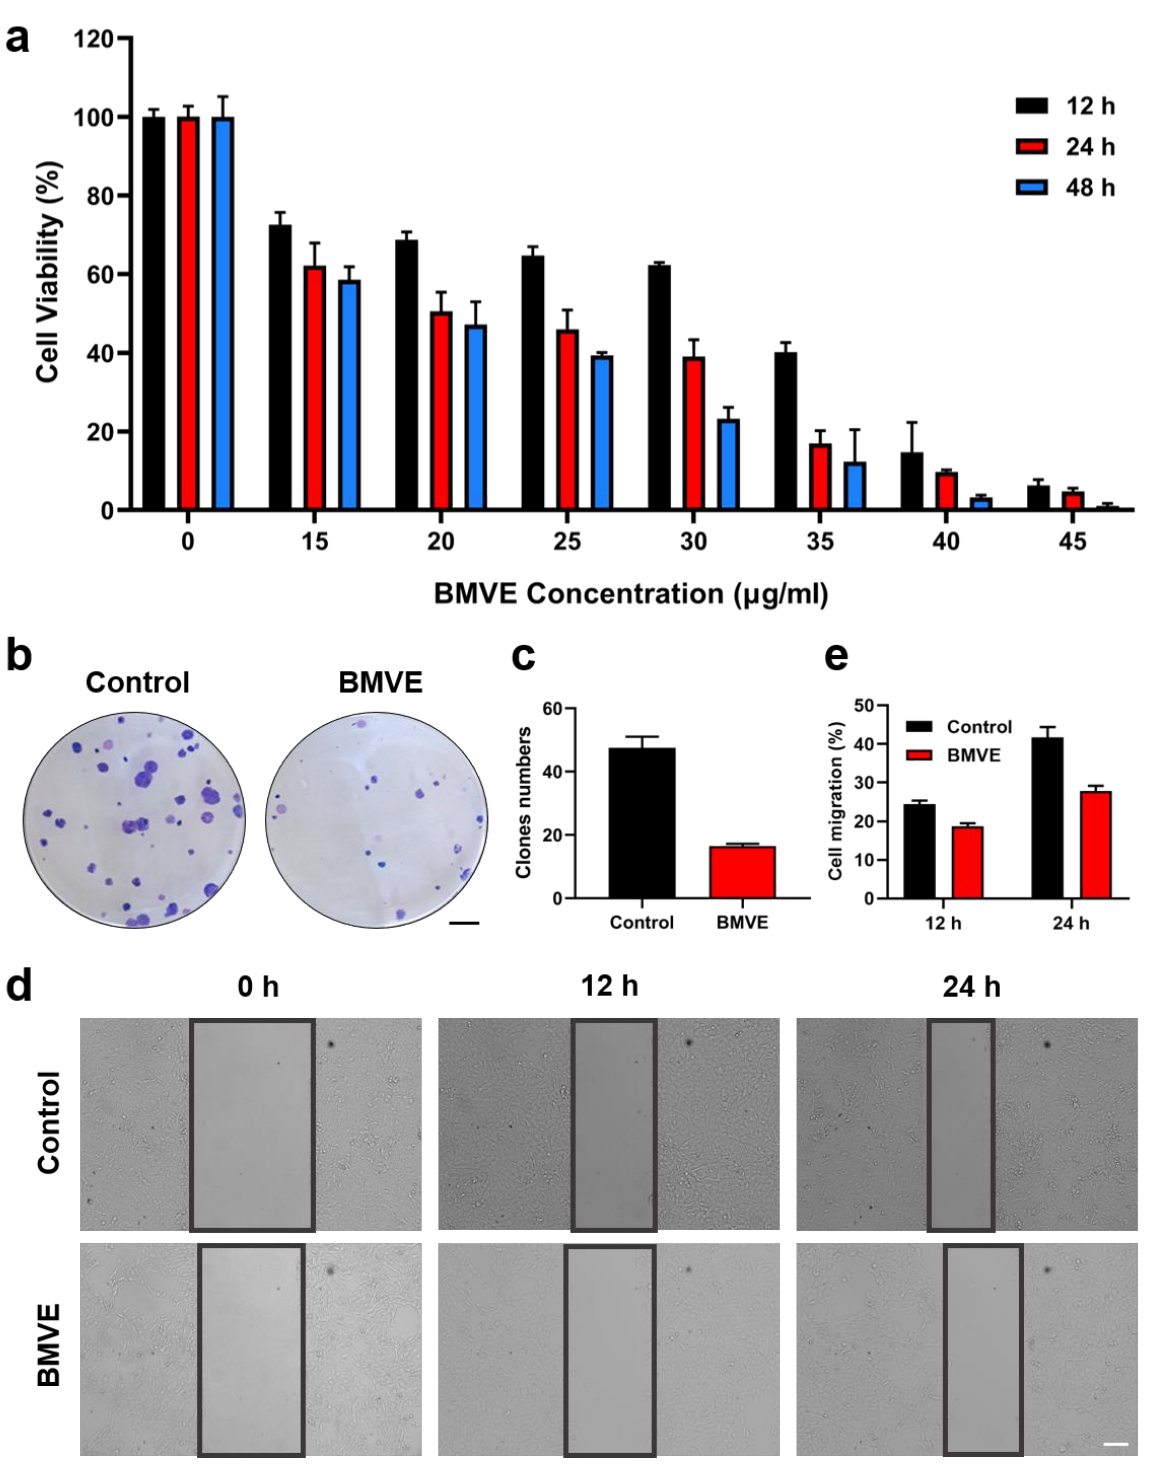
Figure 2. BMVE has anti-proliferation and migration inhibition effects on 4T1 cells. ( a ) CCK-8 assay detected the viability of 4T1 cells after treatment with varying concentrations of BMVE for 12, 24 and 48 h. ( b ) Representative images and ( c ) quantitative statistics of plate colony formation assays of 4T1 cells with or without BMVE treatment (scale bar = 5 mm). ( d ) Representative images and ( e ) quantitative statistics of 4T1 cell-scratching assay with or without BMVE treatment (scale bar = 100 μm).